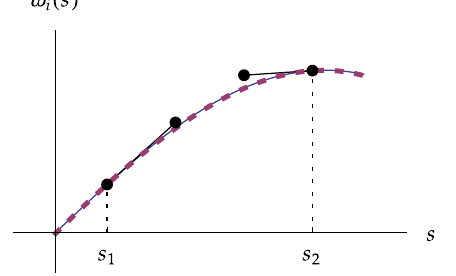
FIG. 1. Schematic of interpolating a function using a cubic Bézier curve. The function to be interpolated is shown as a thin solid curve, and the constructed interpolating Bézier curve is shown by the heavy dashed curve. The large dots indicate the control points derived from the value and slope of the function at s 1 and s 2